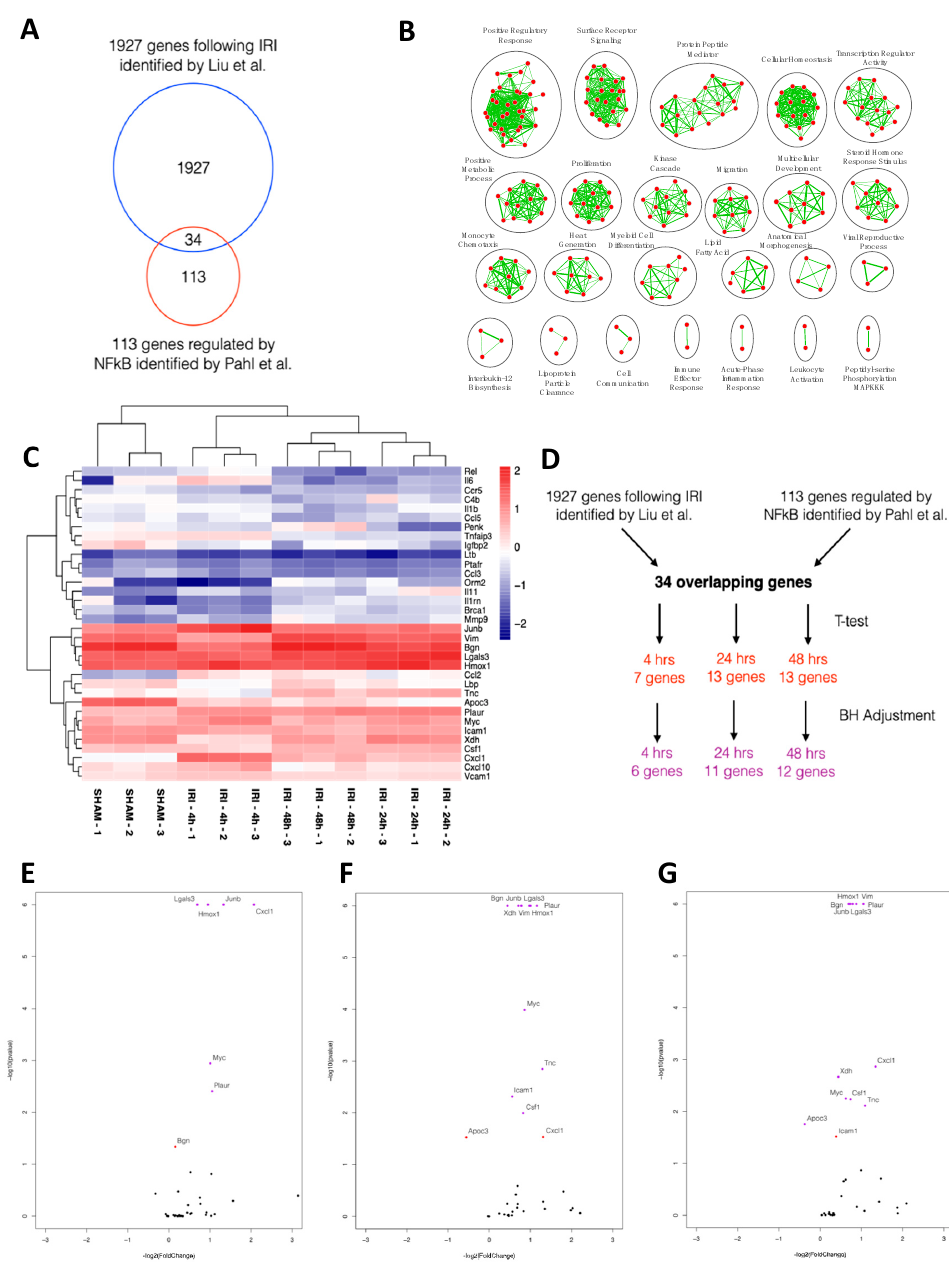
Figure 1. Early IRI is characterized by NF κ B ‐ mediated gene expression. ( A ) Venn diagram of genes identified following IRI and genes regulated by NF κ B [19,20]. ( B ) Significantly enriched biological processes for the NF κ B ‐ mediated genes identified following IRI using Biological Networks Gene Ontology with Benjamini and Hochberg multiple testing correction ( p < 0.05) and then run on Enrichment Map with Jaccard coefficient of 0.5 ( p = 0.001; false discovery rate q ‐ value = 0.05). Edge thickness represents the number of overlapping markers between two connecting nodes. ( C ) Heatmap representation of 34 NF κ B ‐ mediated genes following IRI at 4, 24 and 48 h with Euclidean hierarchical clustering. Log ‐ transformed FPKM values for genes were converted into z ‐ scores using mean values. Higher scores are indicated in red and lower scores in blue. ( D ) Flow diagram showing significant genes mediated by NF κ B at 4, 24 and 48 h following IRI. ( E – G ) Volcano plots of NF κ B ‐ mediated genes following IRI at 4 ( E ), 24 ( F ), and 48 h ( G ). Independent Student t ‐ tests ( p < 0.05; red) with Benjamini and Hochberg multiple testing correction ( q < 0.05; purple) was performed at each